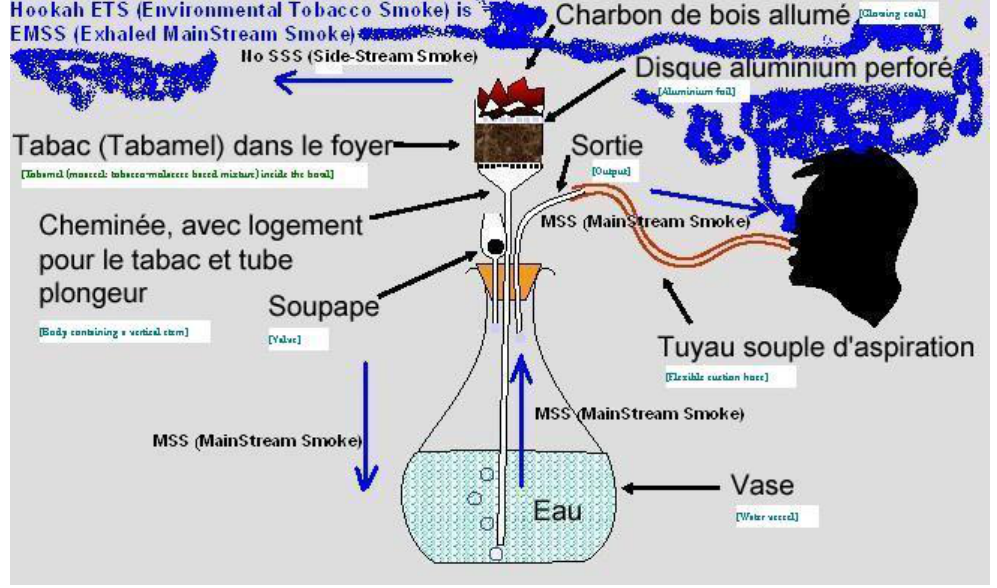
Figure 1. The hookah (narghile, shisha) operating procedure and the diverse smoke